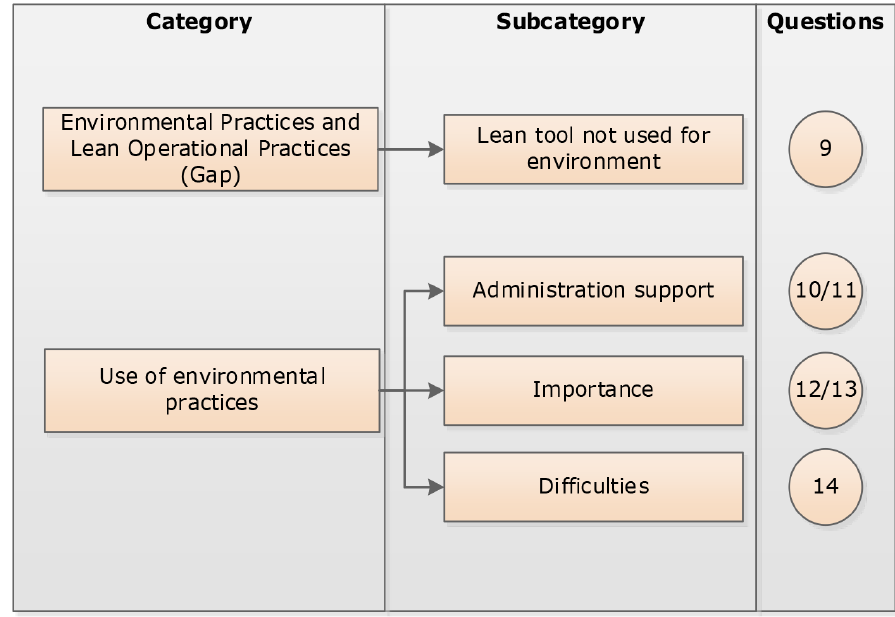
Figure 3. Categorization process for content